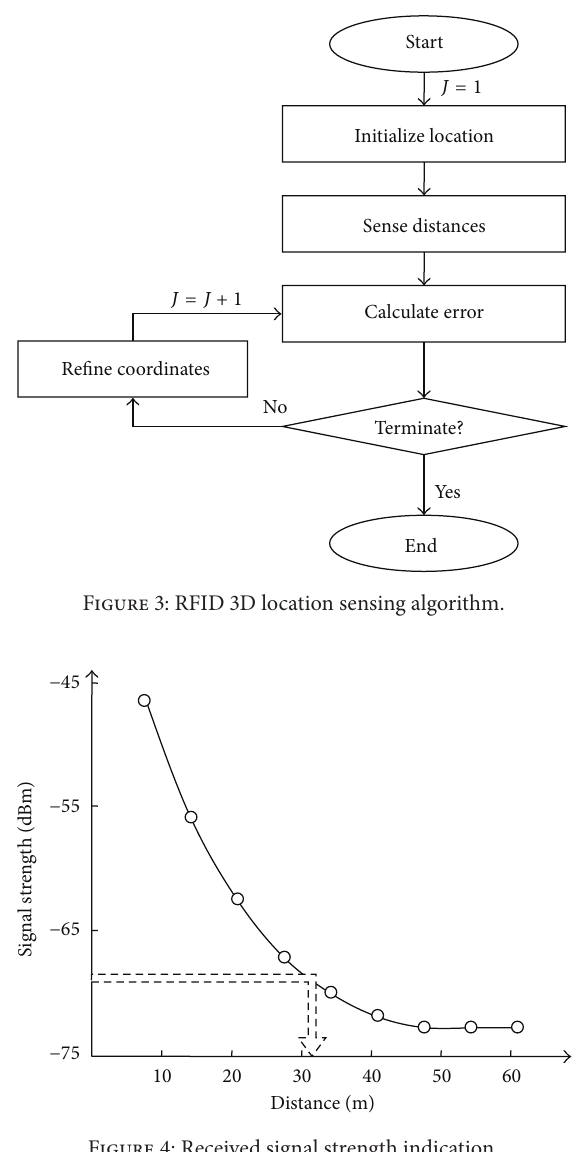
Figure 4: Received signal strength